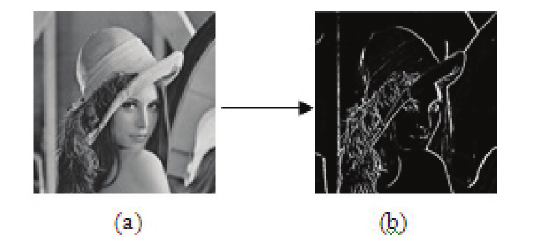
Figure 3: (a) Original Image (b) Edge map at higher (264x 400) scale (66 x 100)